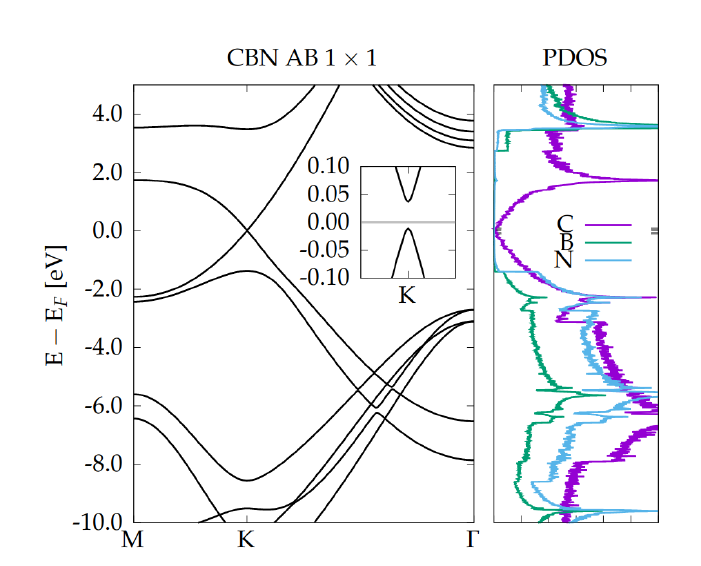
Figure 4. Electronic band structure and Projected Density of States (PDOS) of CBN bilayer in AB stacking in 1 1 unit cell. Inset: zoom at the Dirac point showing the opening of a small band ×